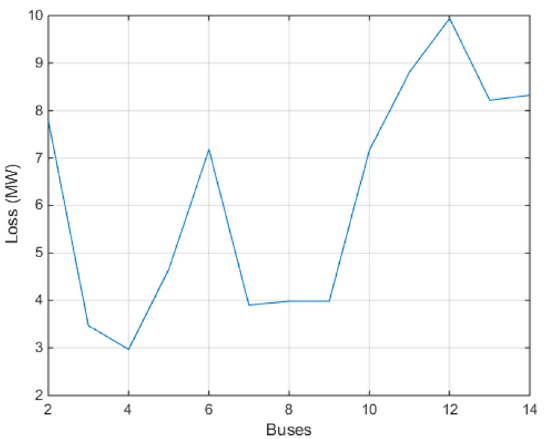
Fig. 6 Comparison of the results for the IEEE 14 bus system using the JAYA algorithm